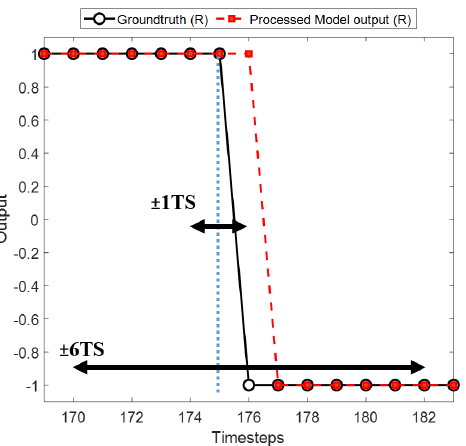
Figure 7. The accuracy is measured with different precision levels termed as tolerance windows ± 1 TS, ± 2 TS, ..., ± 6 TS, where 1 TS is a single timestep of 1 ms measured from the groundtruth event (blue dotted line).